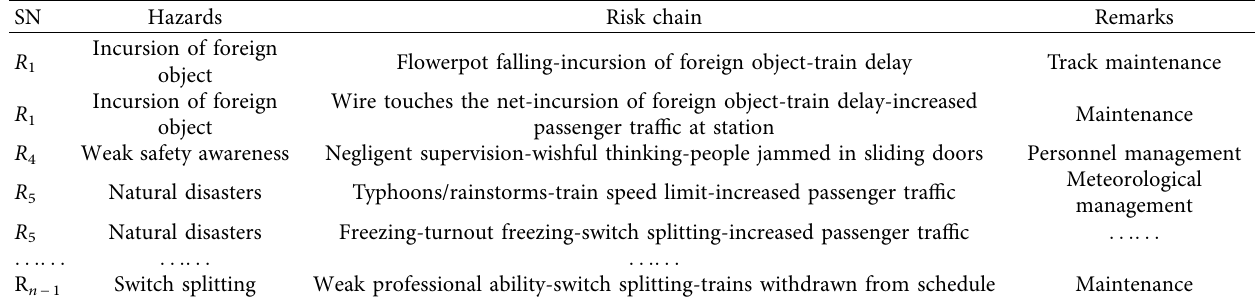
Table 5: Key hazard risk chains.